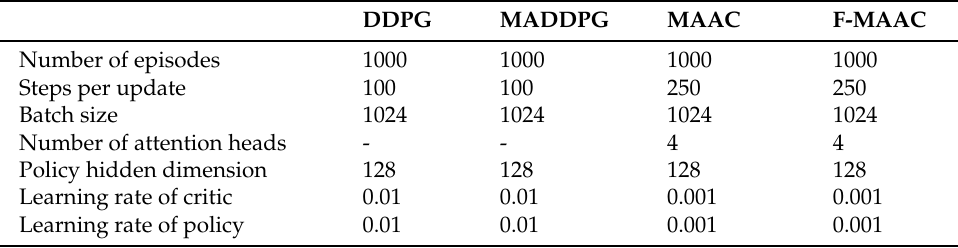
Table 5. Hyperparameter settings of RL